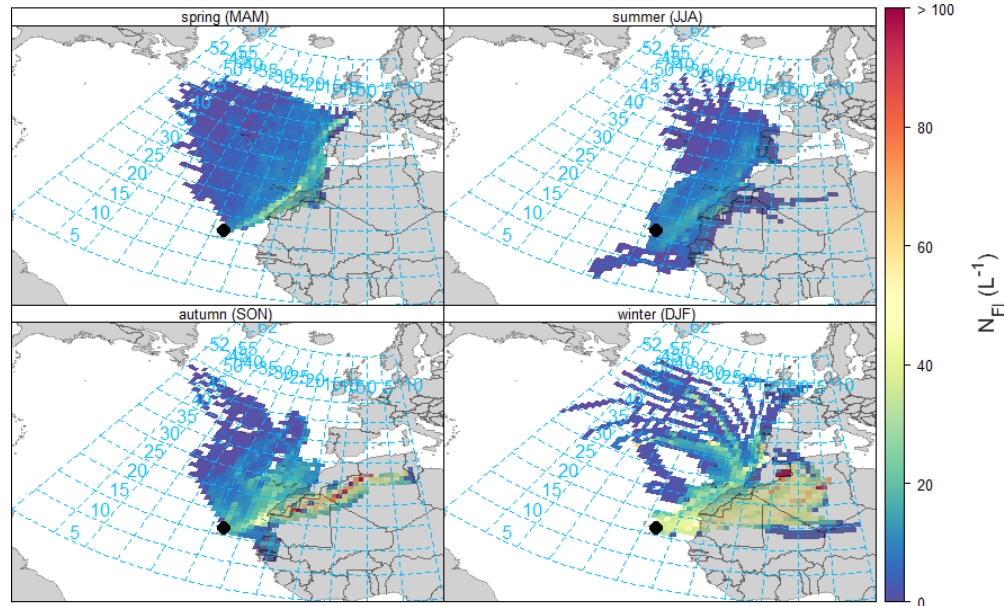
Figure 4. The 120h back-trajectory analysis for fluorescent particle concentrations using HYSPLIT integrated with the Openair package. Note that autumn is using 2015 data, as is the month of December during winter. Spring and summer are using 2016 data. The colour scale has been capped at 100L − 1 for visual purposes and only particles between 0.8 and 10µm have been included.